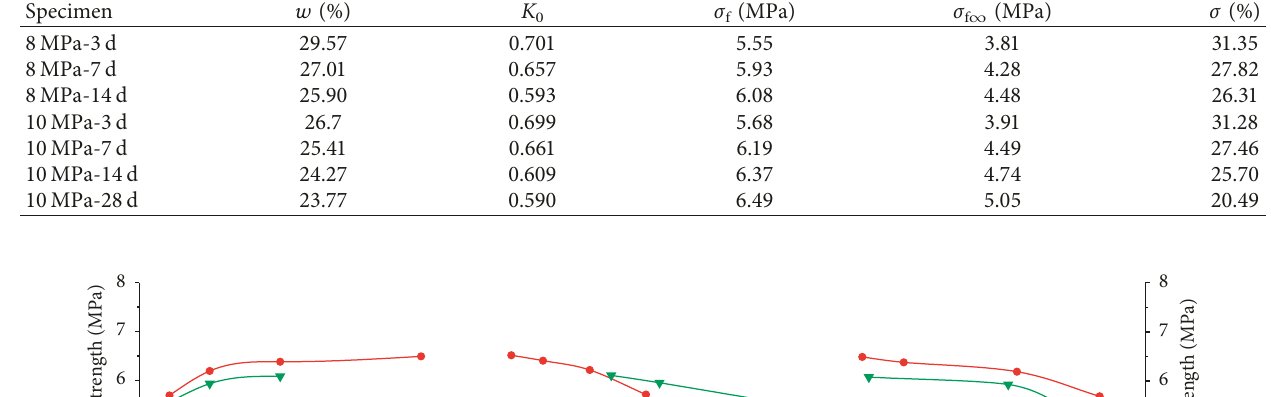
f /d t c and σ f ∞ /d t c vs. t c and